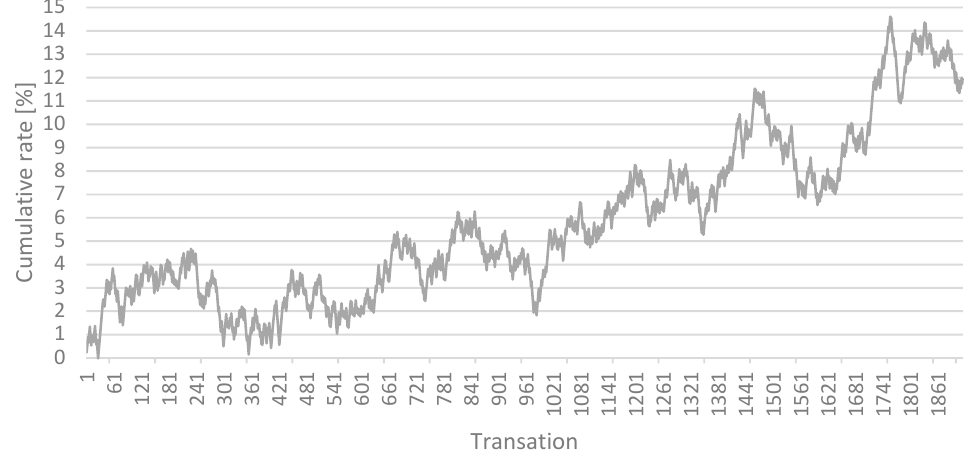
Figure 4. Backtest results for HFT system constructed based on SMBMA(25,3,28,0.2) model. Source: author. Table 3. Prediction table for SMBMA(25,3,28,0.2) model of AUD/NZD, calculated for 01